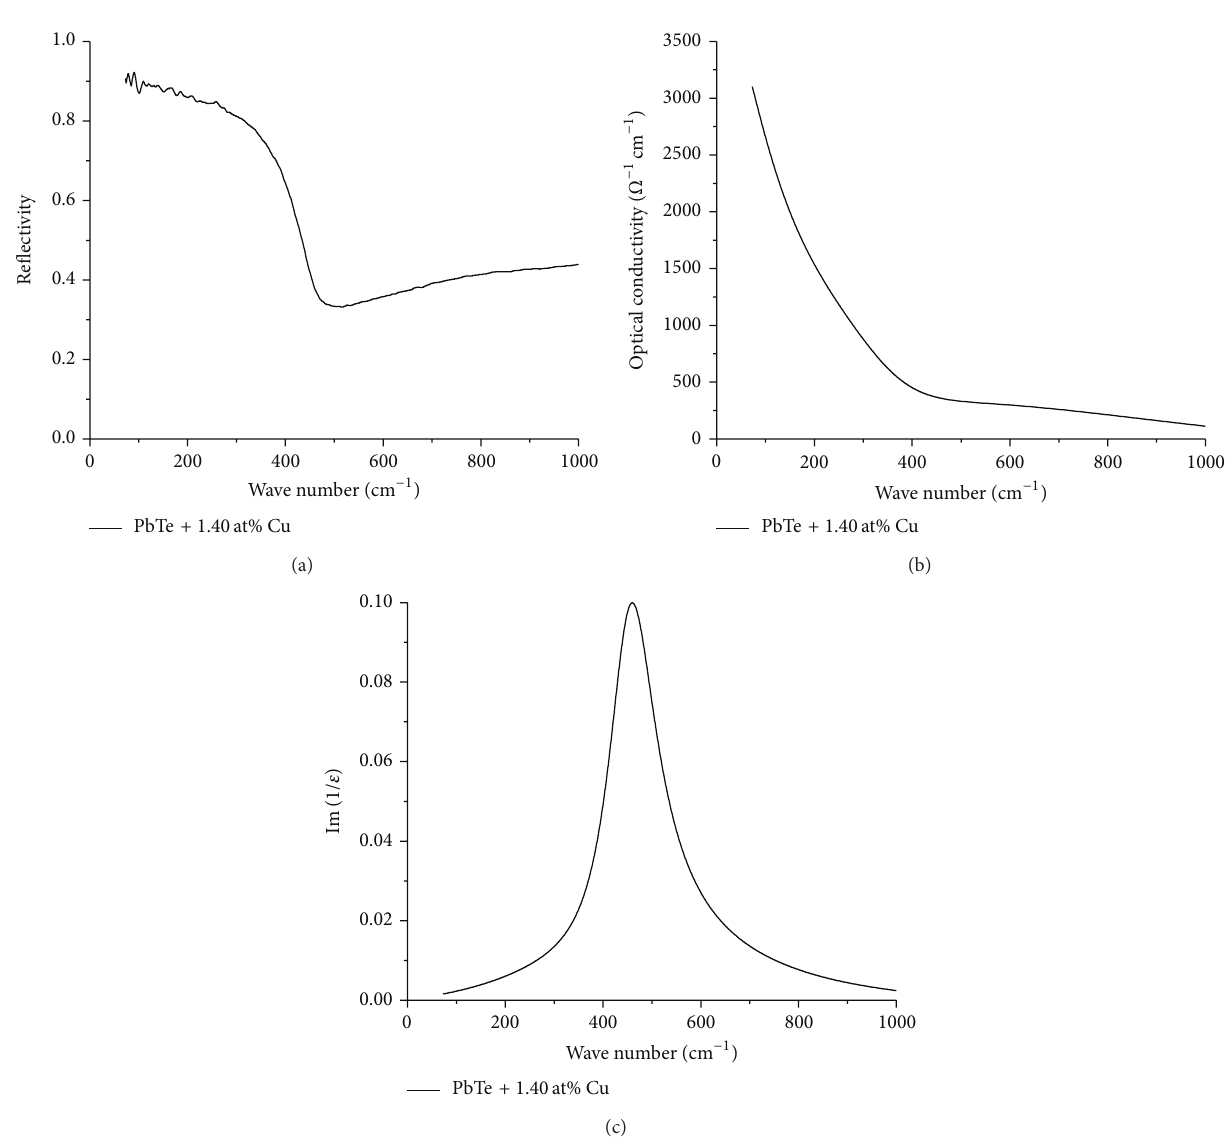
Figure 6: (a) Optical reflectivity diagram for PbTe doped with 1.4 at% Cu, (b) its optical conductivity, and (c) reciprocal values of imaginary part of dielectric constant [Im (1/𝜀)